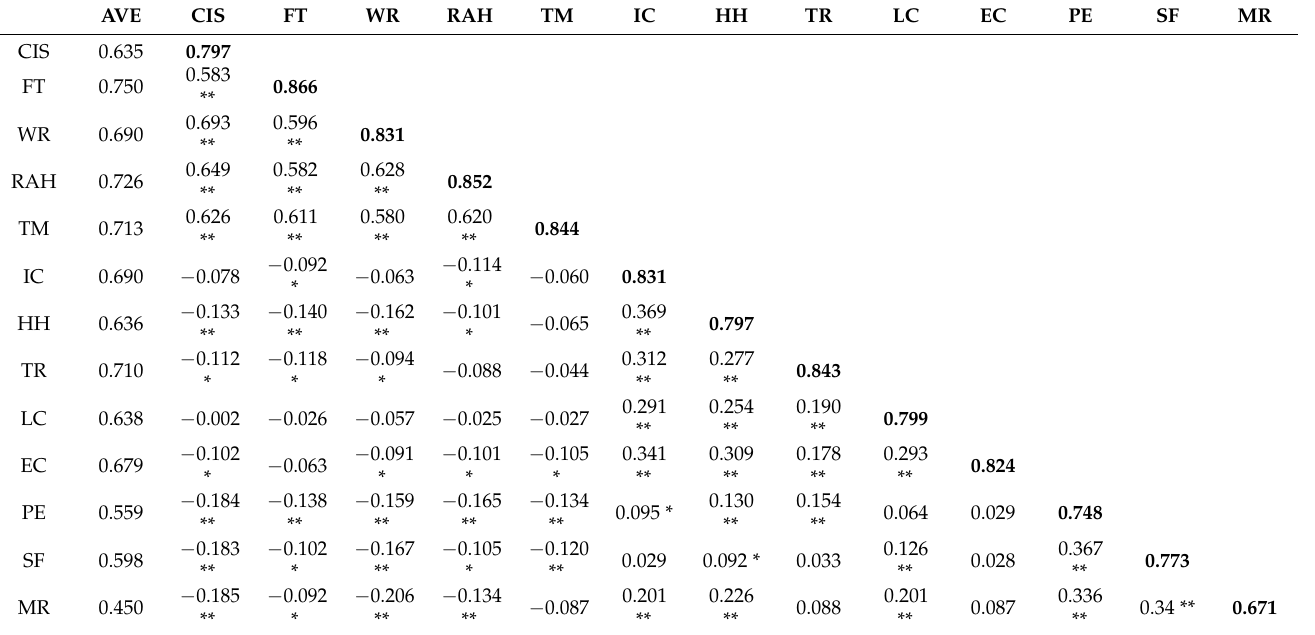
Table 2. Correlation tests for each